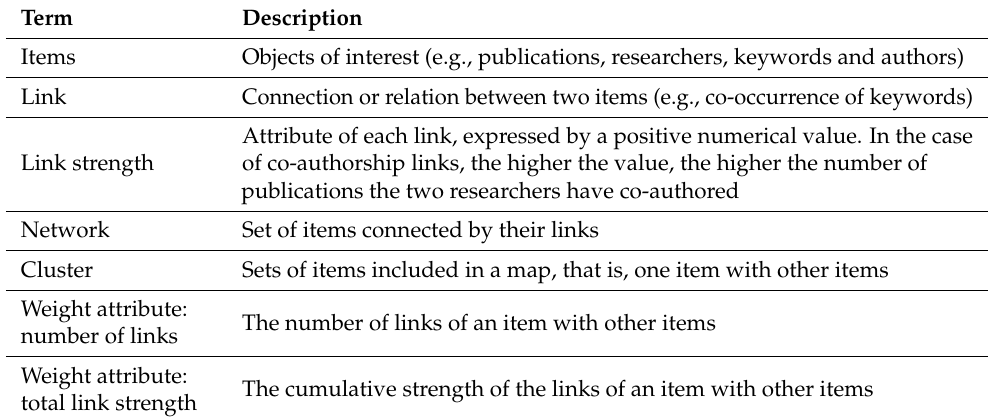
Table 1. Analysis terms used by VOS viewer and CiteSpace. Term Description